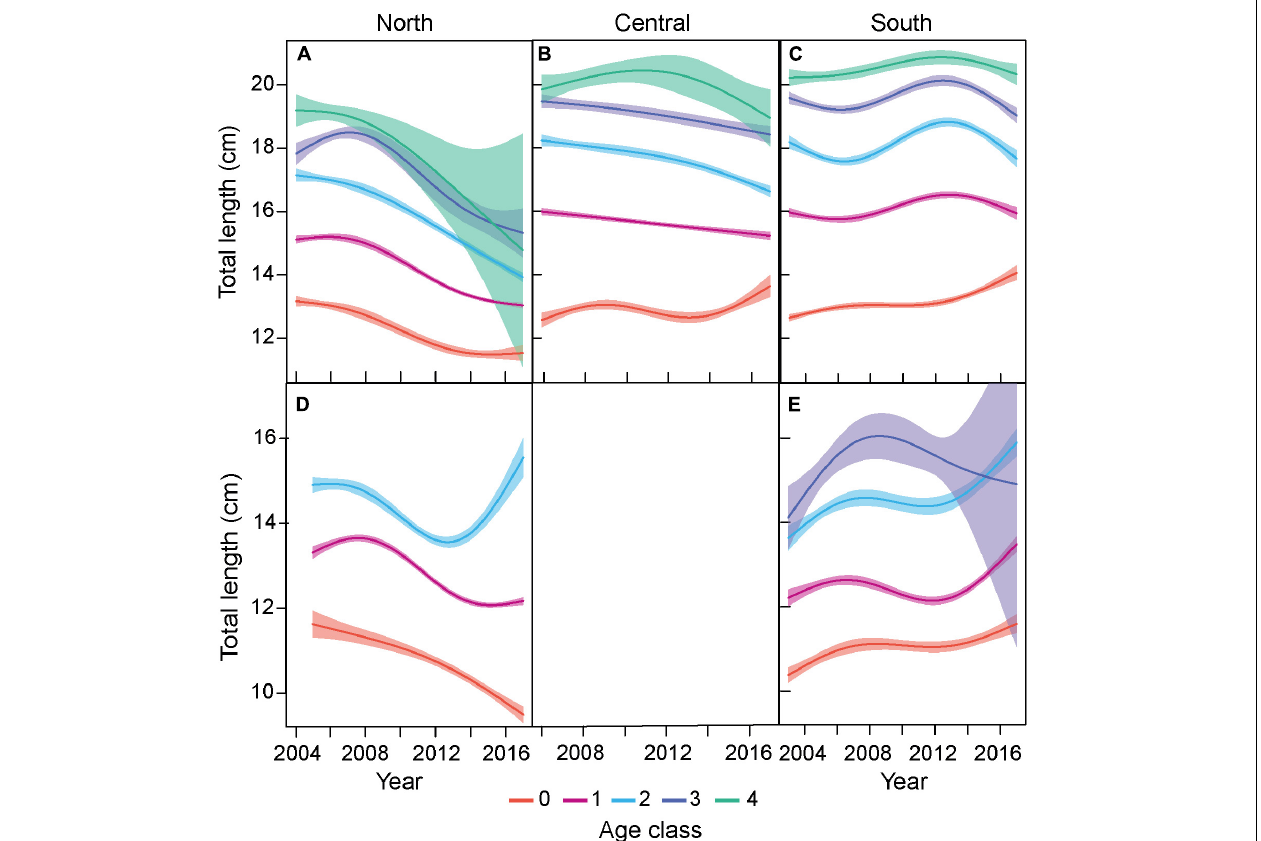
FIGURE 3 | Long-term changes in total body length at age for sardine ( Sardina pilchardus ) and anchovy ( Engraulis encrasicolus ). Partial effect of the GAMs model are represented for each species and area; sardine North (A) , Central (B) , South (C) ; anchovy North (D) , south (E) . Lines correspond to the fit of the GAM model. The shaded areas indicate the 95% confidence interval. Only age classes with significant effects are